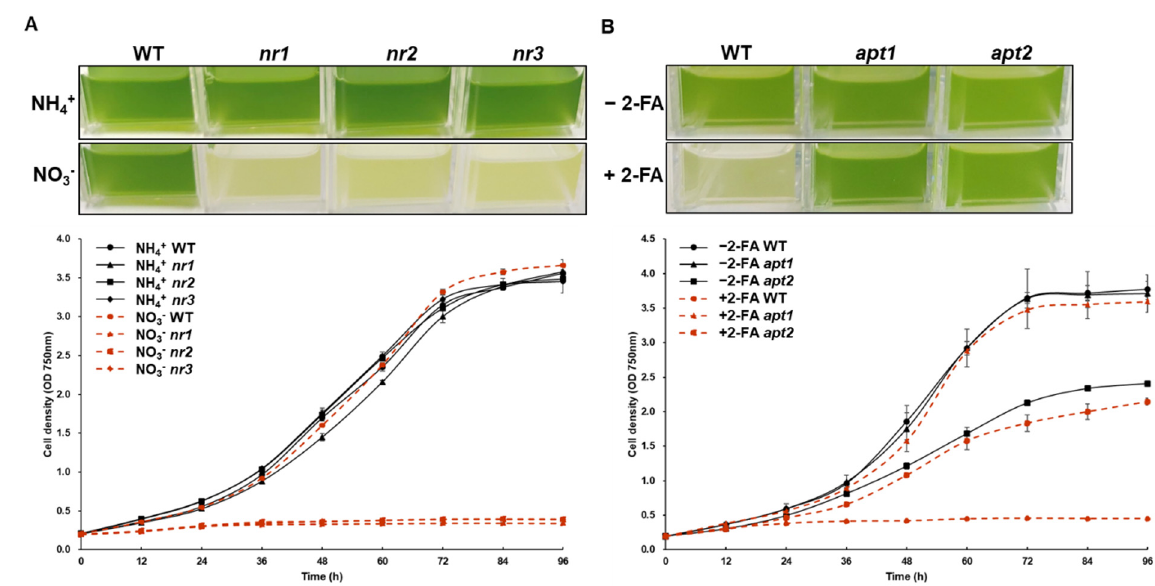
Figure 5. Growth analysis of NR- and APT-edited mutants compared to the WT. ( A ) The growth of nr mutants was fully inhibited in nitrate-supplemented medium. ( B ) Determination of cell growth of apt mutants in 2-fluoroadenine (2-FA) containing medium. apt mutants acquired resistance to 2-FA and could grow well, whereas the growth of WT was fully suppressed. These results indicated that the edited genes were not functional. Growth measurement was performed triplicate independently ( n = 3).